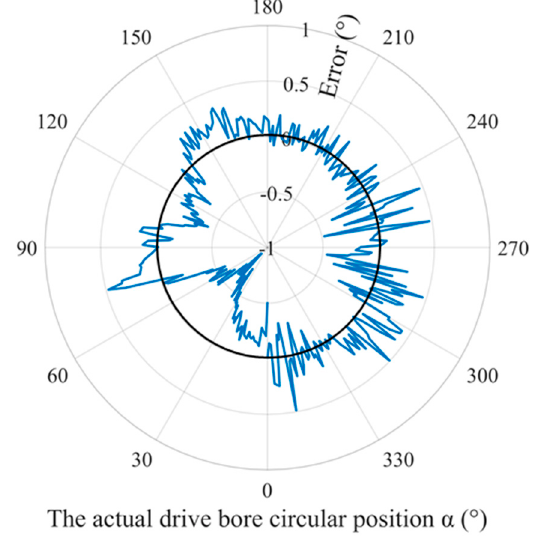
Figure 11. The validation result of the proposed machine ‐ vision ‐ based measuring method.